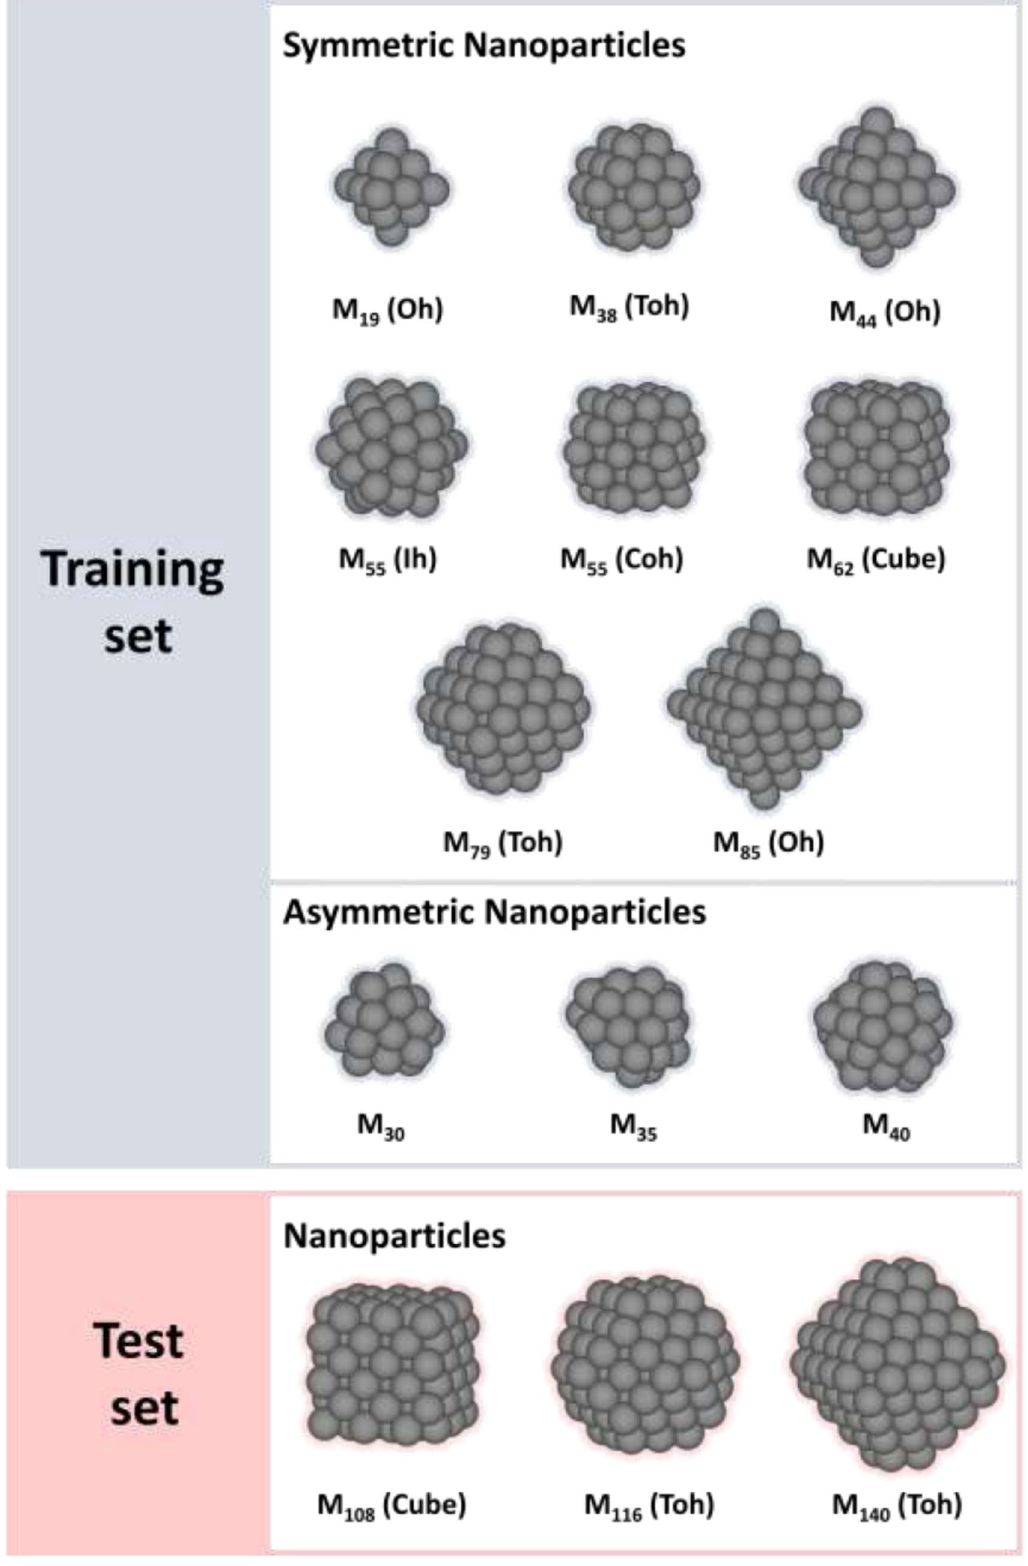
Figure 1. Training and test datasets for DOS prediction of NPs. In the NP structures, COh, Ih, Oh, TOh, and Cube indicate cuboctahedral, icosahedral, octahedral, tetraoctahedral, and cubic structures,